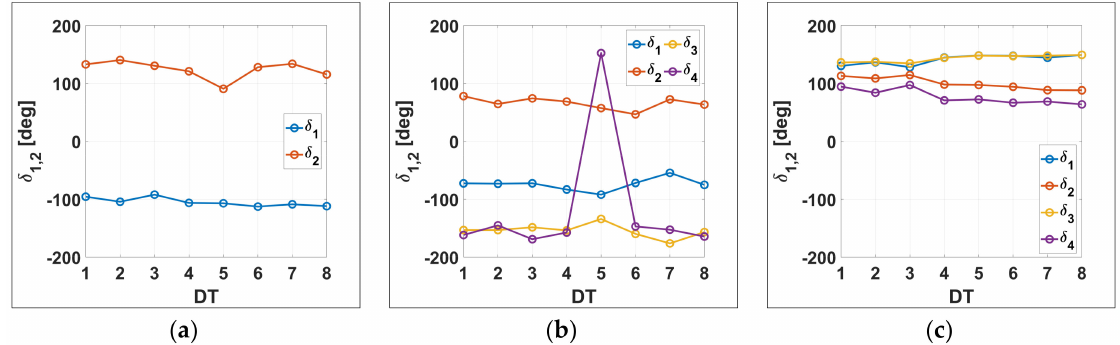
Figure 8. Phase estimates of ( a ) δ 1,2 by the Van Zyl method, ( b ) δ 1,2,3,4 by the Quegan method, and ( c ) δ 1,2,3,4 by the Villa method, according to the selected DT.